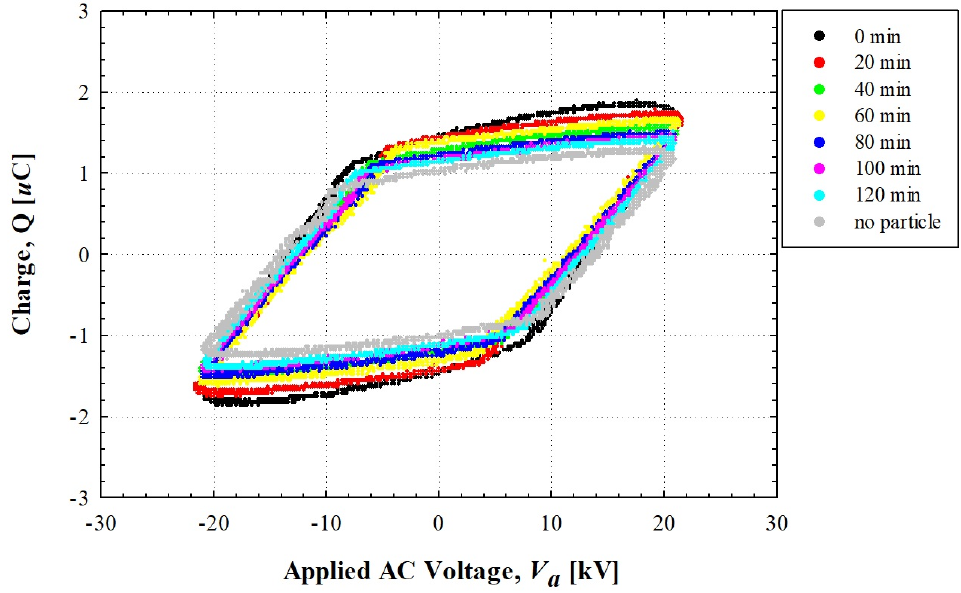
Figure 9. Q-V Lissajous curve based on treatment time at 15 kV 100 Hz.